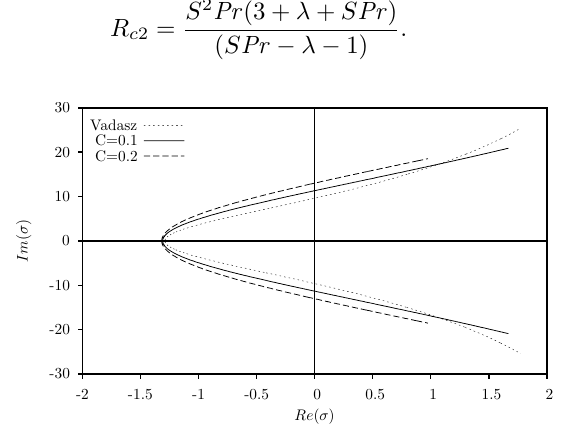
Figure 1. A graph of C and Ra showing the direct proportionality between them. Eq. (4.2) yields three eigenvalues, and the smallest of which α 1 is always real and negative over the whole range of parameter values. The other two are real and negative at slightly supercritical values of R , such that the convection fixed points are stable, that is, simple nodes. These two roots move on the real axis towards the origin as the value of R increases. For Pr = 10 and λ = 8 / 3, these roots become equal when R ∼ = 2 . 445 for C = 0 . 1 and R ∼ = 3 . 54 for C = 0 . 2 compared with R ∼ = 1 . 35 for C = 0 (Vadasz case). It is exactly at this point that these two roots become a complex conjugate. In any case, they still have negative real parts, and so the convection fixed points are stable, that is, spiral nodes. Both the imaginary and real parts of these two complex conjugate eigenvalues increase and extend over the imaginary axis as the value of R increases. The real part becomes nonnegative at a value of R given by